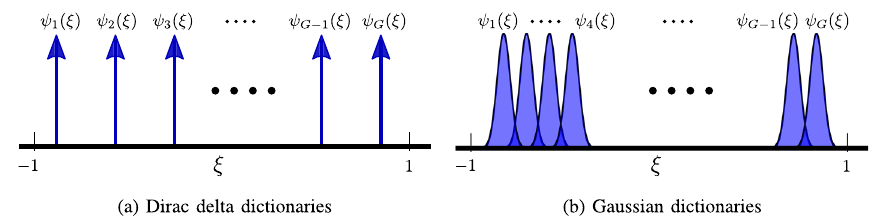
Fig. 2 Examples of Dirac delta (disjoint supports) and Gaussian dictionaries (overlapping